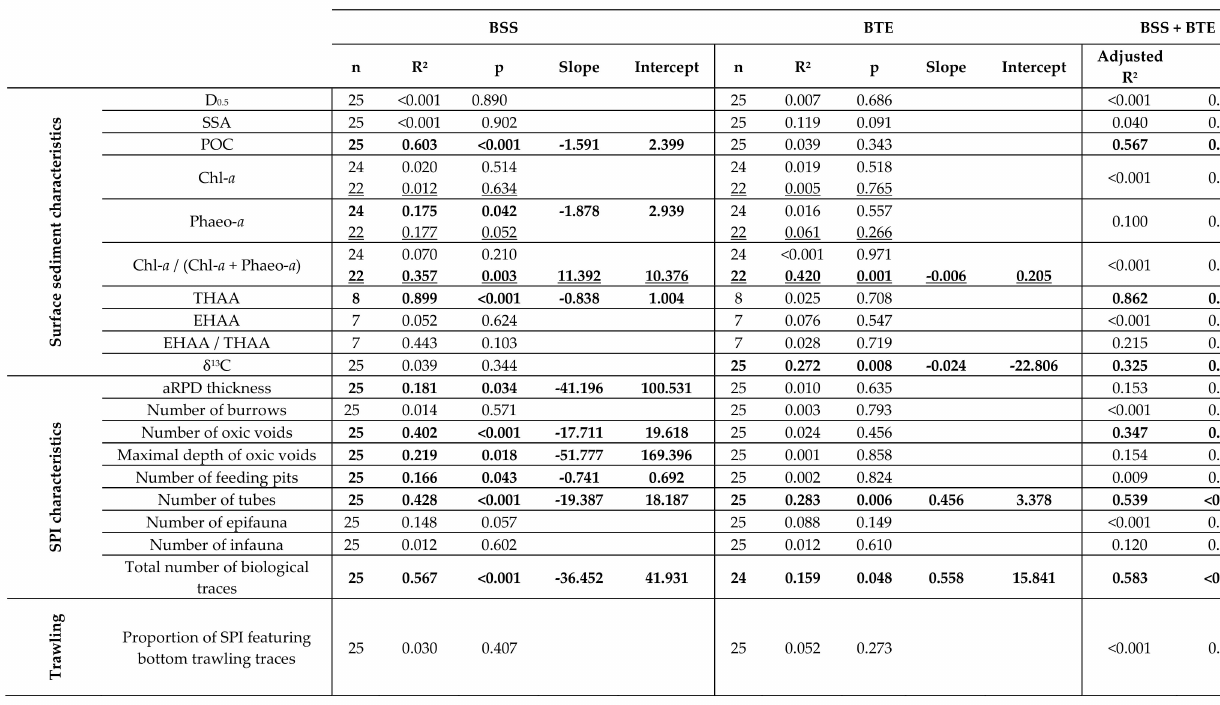
Table A3. Determination coefficients (R 2 ), associated probability levels ( p ), slopes, and intercepts of the simple linear regression models linking 95th percentile of Bottom Shear Stress (BSS) and one-year summed Bottom Trawling Effort (BTE) within cells containing sampled stations, and assessed parameters within the distal part of the WGMP. Adjusted determination coefficients (R 2 ) and associated probability levels ( p ) of the multiple linear regression models linking the combination of BSS and BSS with assessed parameters within the distal part of the WGMP. Bold types are indicative of significant ( p < 0.05) correlations and underlined types correspond to simple linear regression models without the outliers constituted by stations AN and